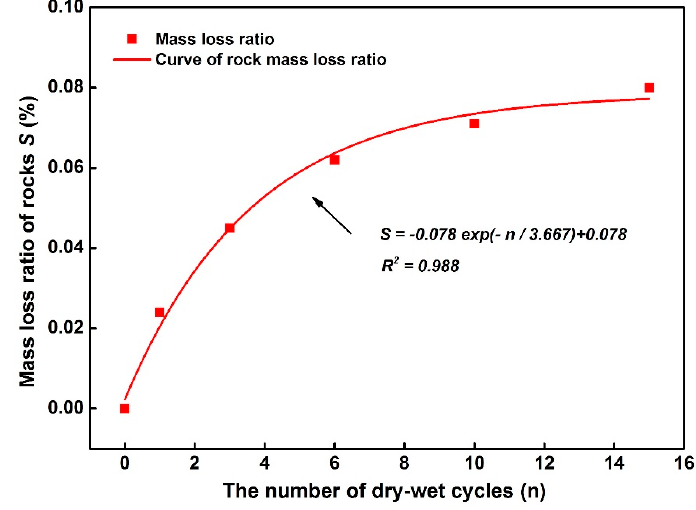
Figure 5. The relationship between rock mass loss ratio and the number of dry-wet cycles.